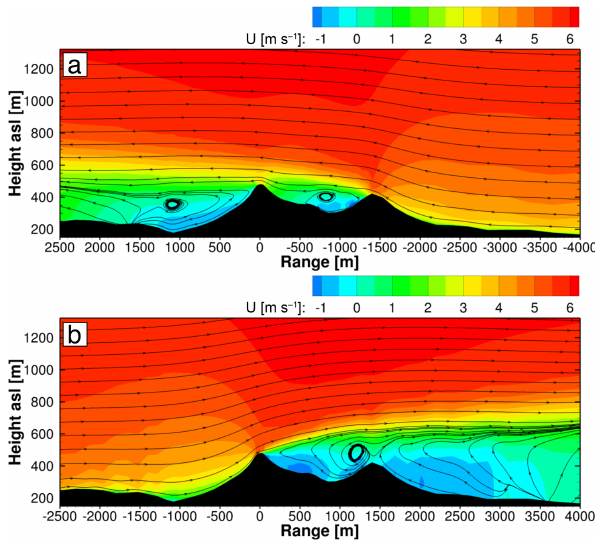
Figure 5. Simulated wind flow in a vertical plane indicated by the dashed line in Fig. 4: (a) northeast winds; (b) southwest winds. The coordinate system origin corresponds to the wind turbine